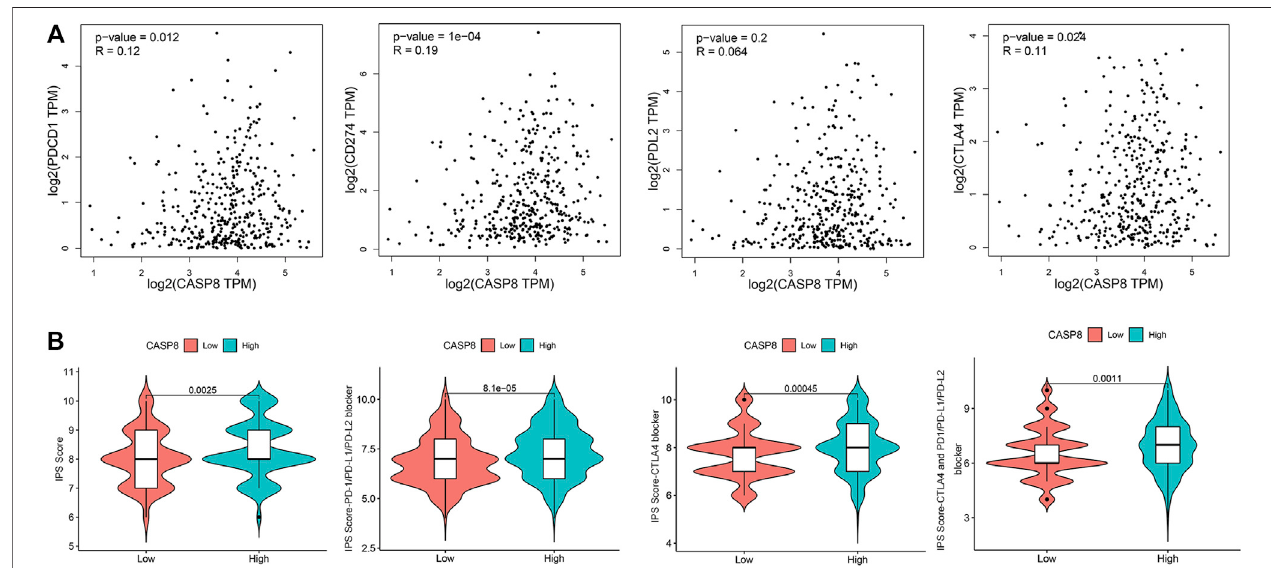
FIGURE 8 | Relationship of CASP8 with immune checkpoints and response to immunotherapy in bladder urothelial carcinoma. (A) Correlation of the CASP8 expression with PDCD1, CD274, PDL2, and CTLA4 using the GEPIA dataset. (B) The impact of CASP8 expression on Immune cell Proportion Score (IPS) and the response to different immunotherapy combinations. CTLA4, cytotoxic T-lymphocyte-associated protein four; PD1, programmed cell death protein 1; PD-L1, programmed cell death ligand 1; PD-L2, programmed cell death ligand